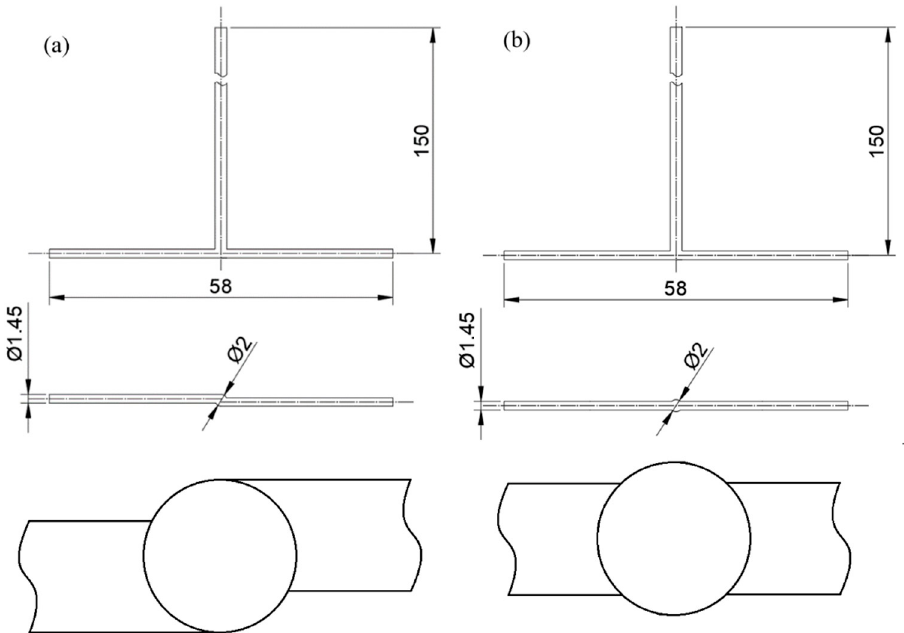
Figure 1. Geometries of ( a ) tangential inlets V-type and ( b ) coaxial inlets T-type impinging jet reactors (all dimensions are given in mm).